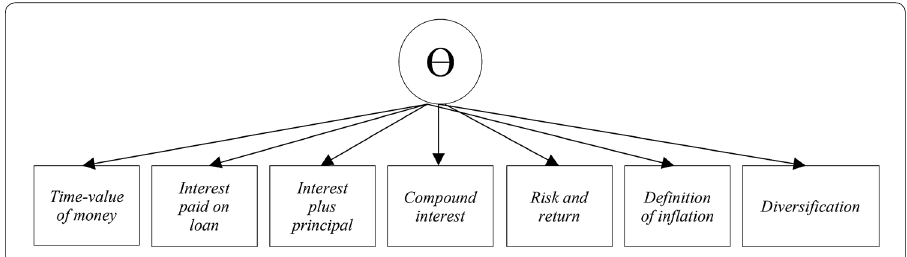
Fig. 2 Unidimensional Rasch model: financial knowledge measurement instrument. The structure of the unidimensional model is displayed, consisting of the expected seven items that should load to the composite factor of financial